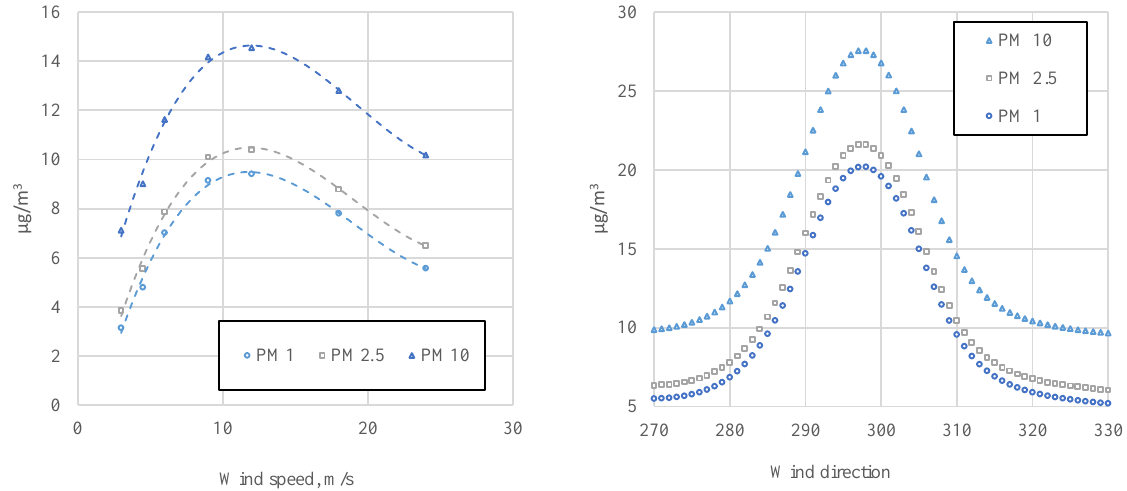
Figure 5. Comparison of modeled exhaust gas plume structure.